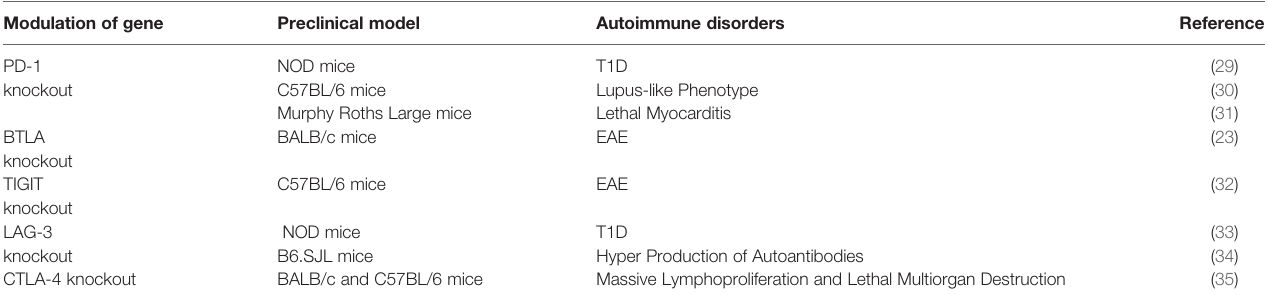
TABLE 1 | Autoimmune disorders caused by the knockout of ICP